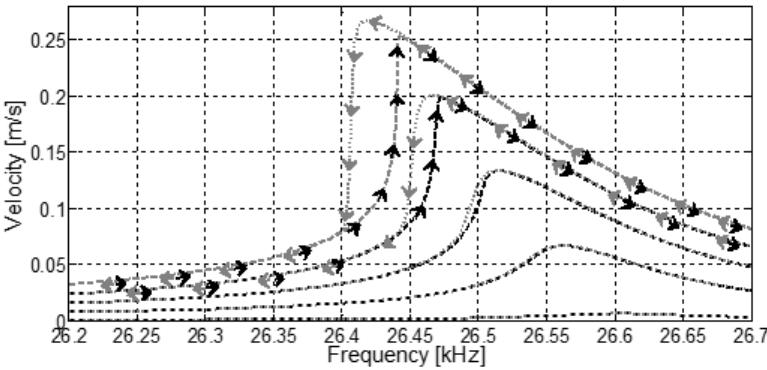
Figure 5. Velocity response curve obtained by the model. Here, the input voltage was increased from 1 V to 5 V, with steps of 1 V. Black curves were obtained by increasing the frequency, whereas gray curves are associated with those responses obtained during frequency